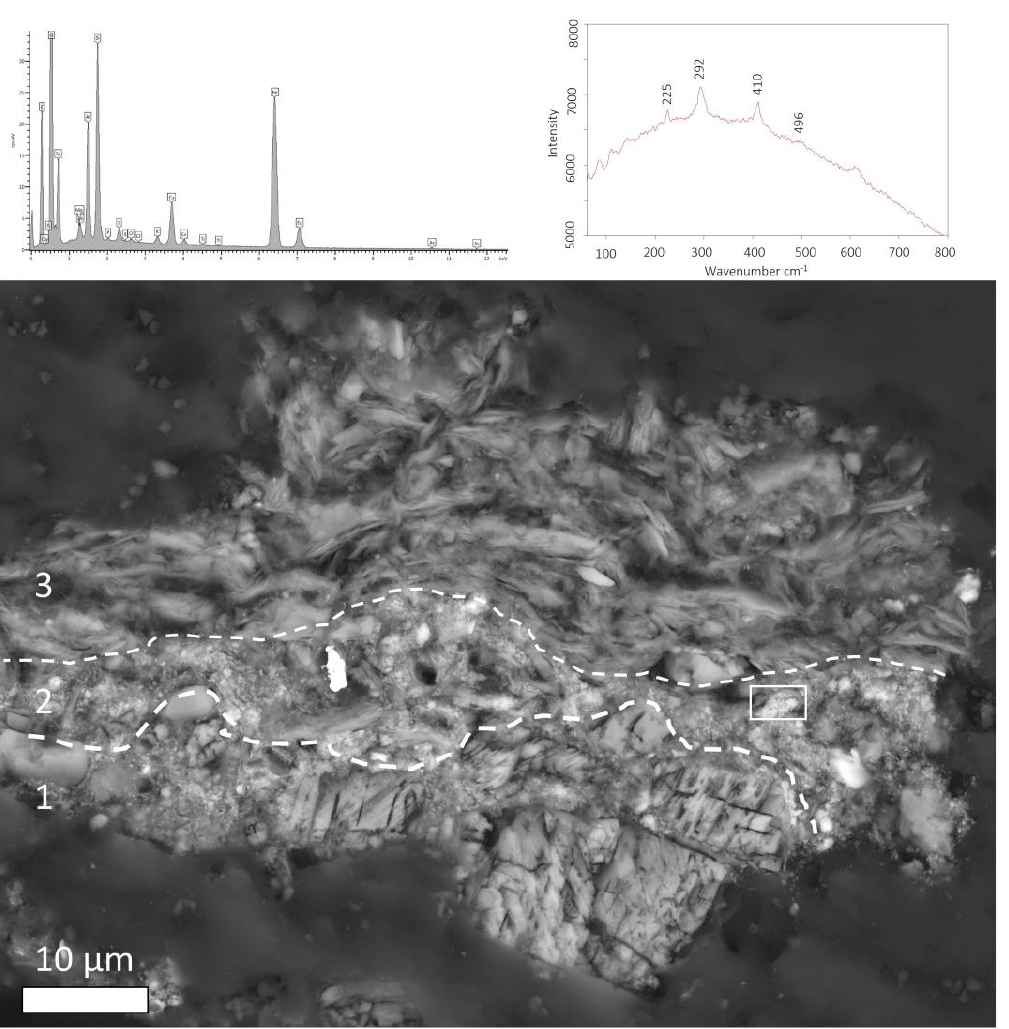
Figure 9. BSE image of cross section 4R ( bottom ) showing the paint stratigraphy of the hair (1. Mar- ble substrate; 2. Paint layer; 3. Accretion); EDS spectrum ( top left ) of a sporadic cinnabar particle in the paint layer (very bright particle at the center of layer 2); Raman spectrum of the hematite particle indicated in the figure ( top right ).